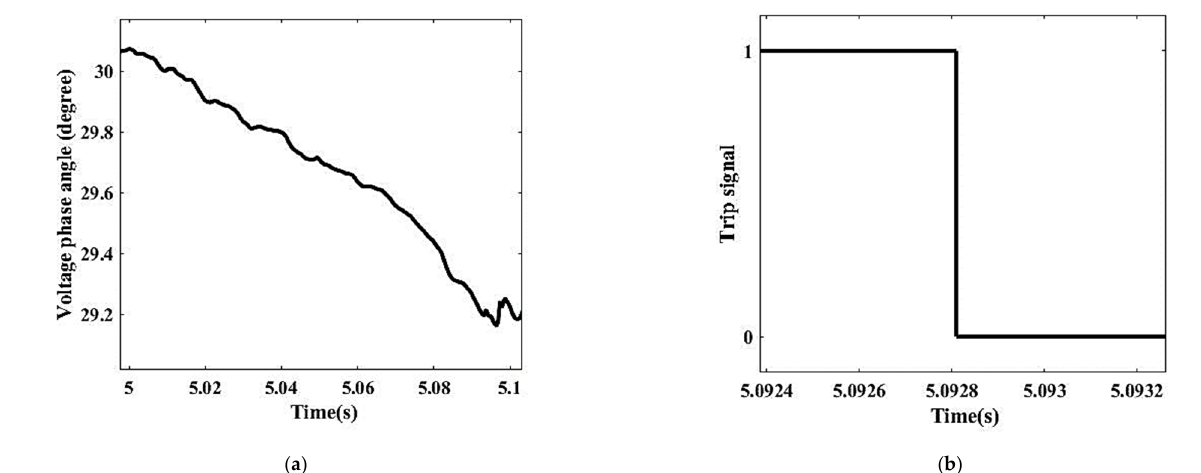
Figure 6. Islanding at small power mismatch situation ( a ) magnitude of voltage phase angle magnitude vs. time ( b ) detection time.